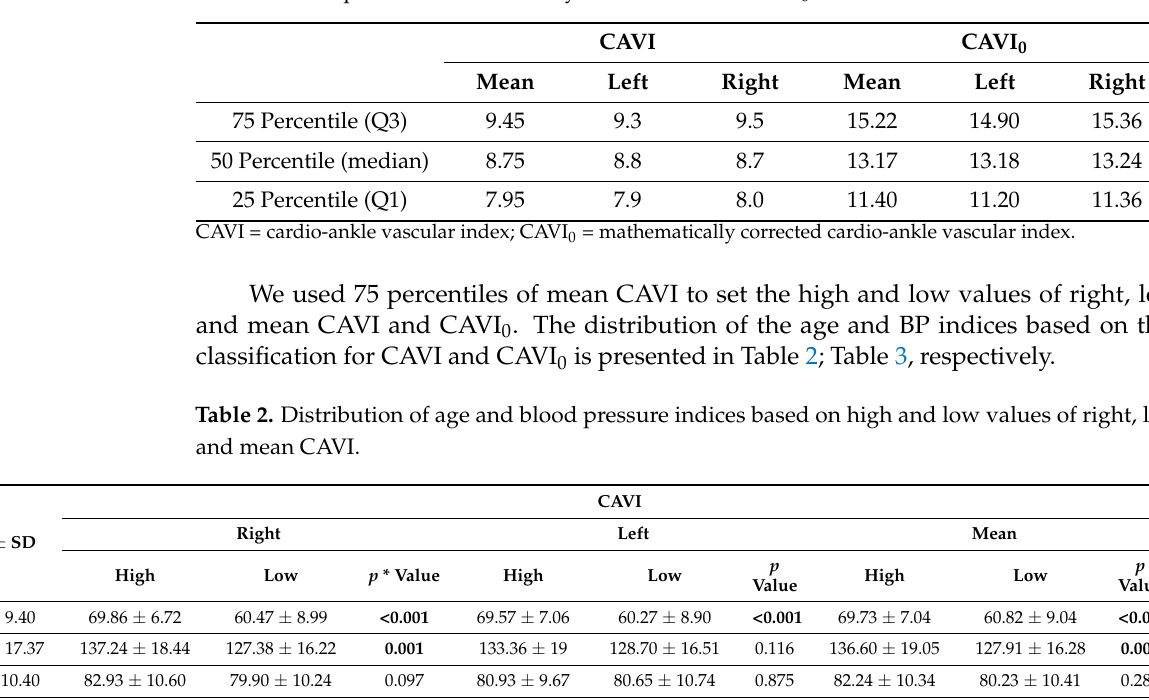
Table 1. Descriptive distribution analysis for CAVI and CAVI 0 .